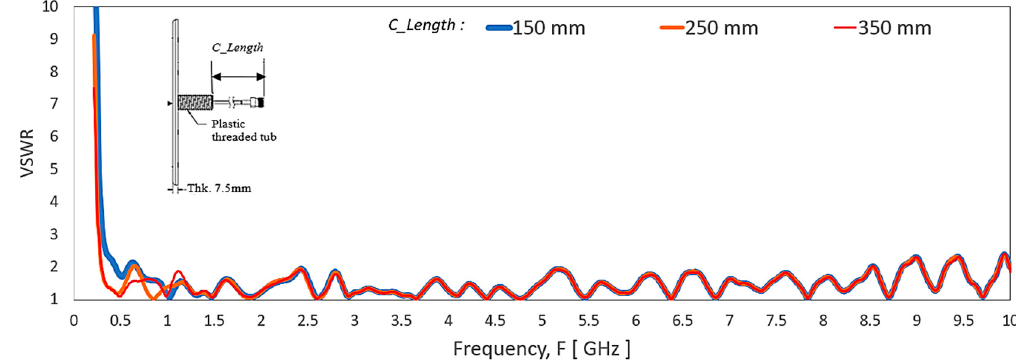
Figure 13. Simulated VSWR of the antenna with varying of cable length, C_Length .